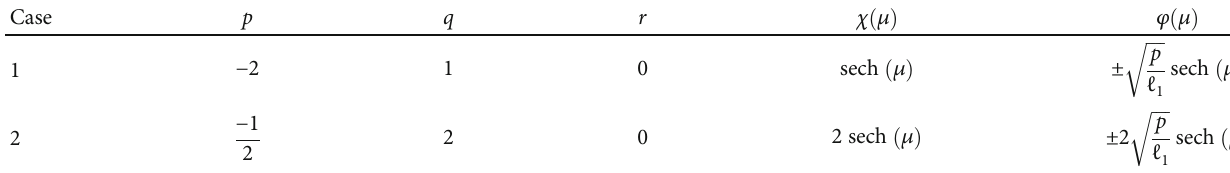
Table 4: All possible solutions for wave Equation (14) when p < 0 and m ⟶ 1 .